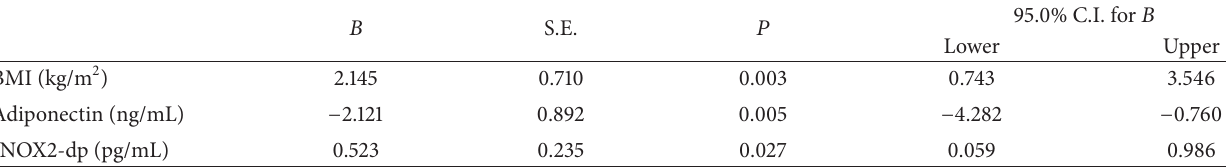
Table 4: Stepwise multiple linear regression analysis of independent predictors of serum cytokeratin-18 levels in 209 subjects with